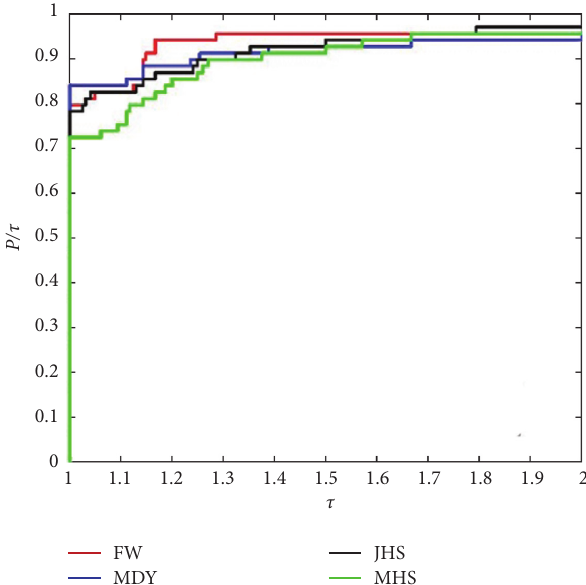
Figure 3: Performance profile on the number of function evalu- ation (FW versus MDY, JHS, and MHS).